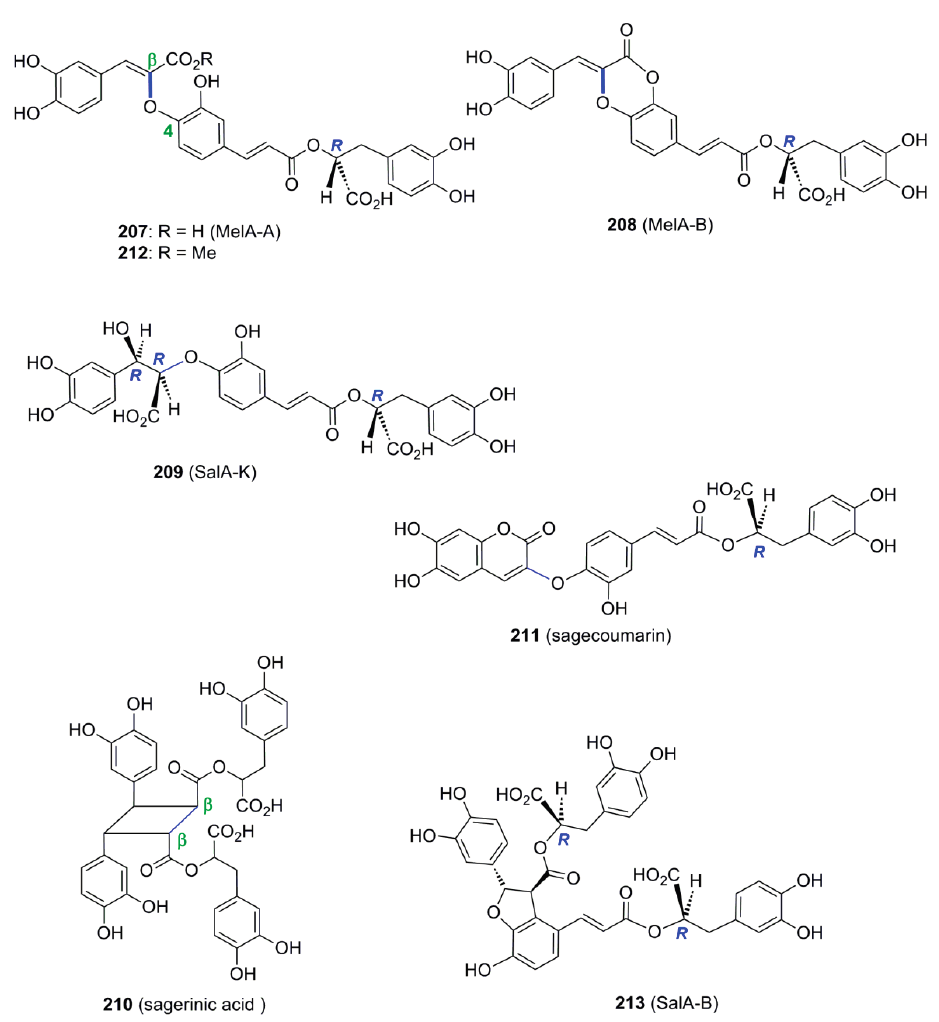
Figure 15. The structures of melitric and salvianolic acids as well as of sagerinic acid and sagecoumarin.